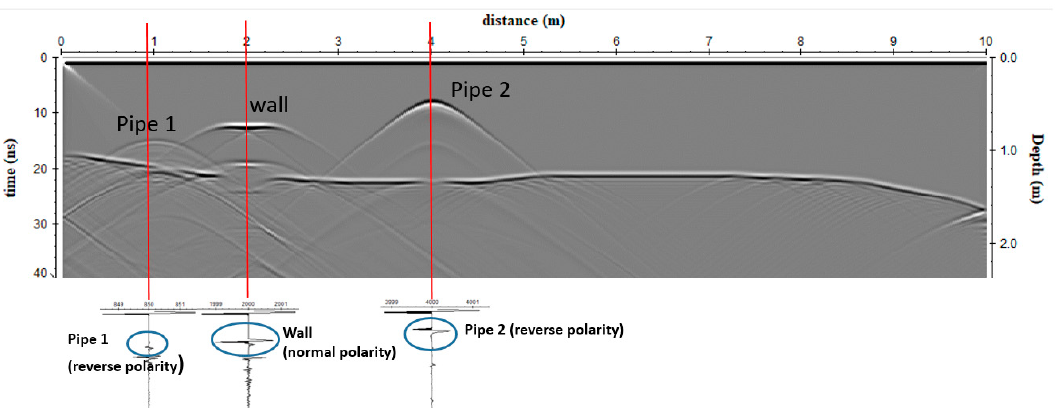
Figure 6. Forward model: radar section with the shown polarity of the electromagnetic (EM) wave reflected from pipe 1, pipe 2 and the wall.